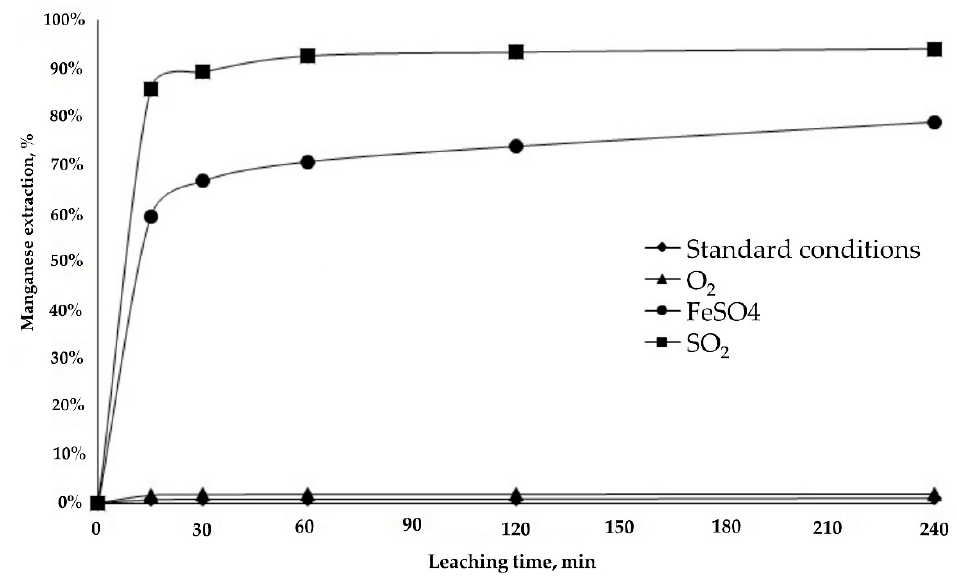
Figure 9. Manganese extraction from LB sample.